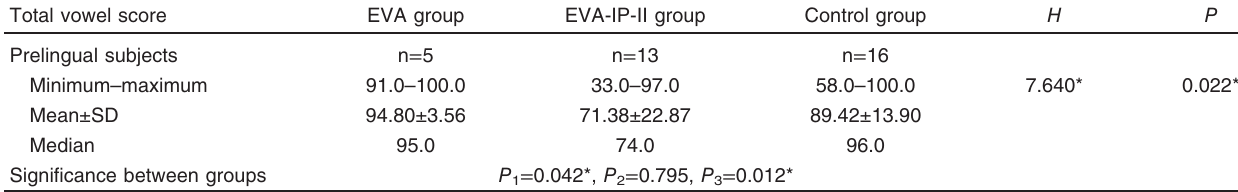
Table 7 Vowel perception test scores among the prelingual subjects of the three groups Total vowel score